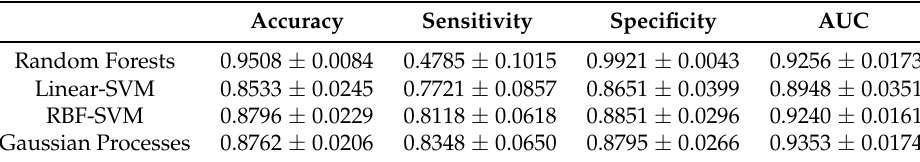
Table 3. AUC, accuracy, sensitivity and specificity related to the bright-lesion detection on E-OPHTHA exudates database for each classification method using a decision threshold δ =